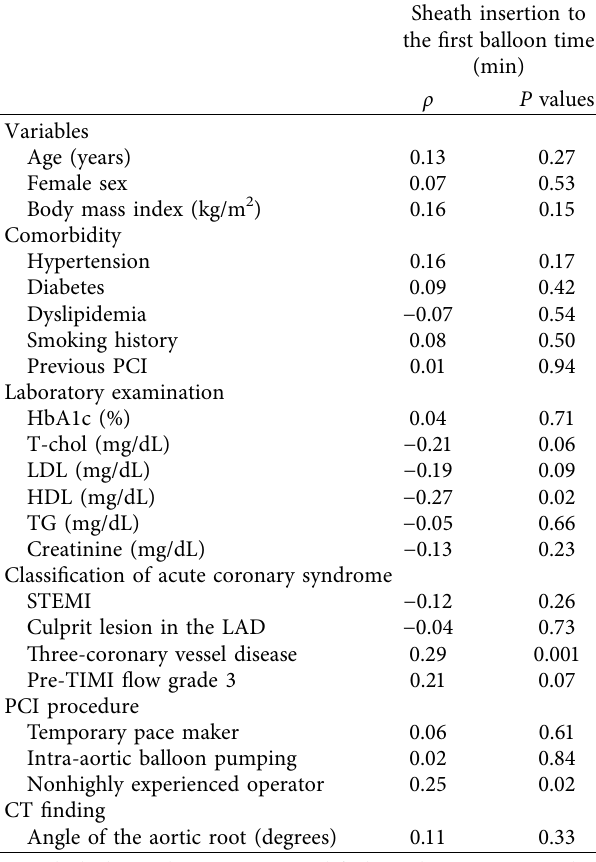
Table 2: Spearman regression analysis of the sheath insertion to the frst balloon